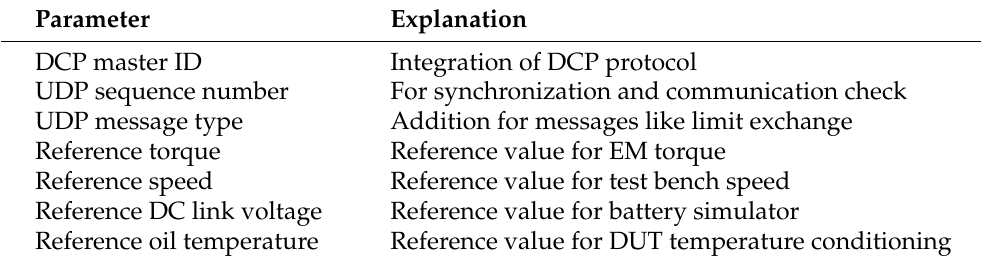
Figure 5. Communication protocol stack utilized in this research. Table 5. Data sent from the ICE test bench (master) to the EM test bench (slave).